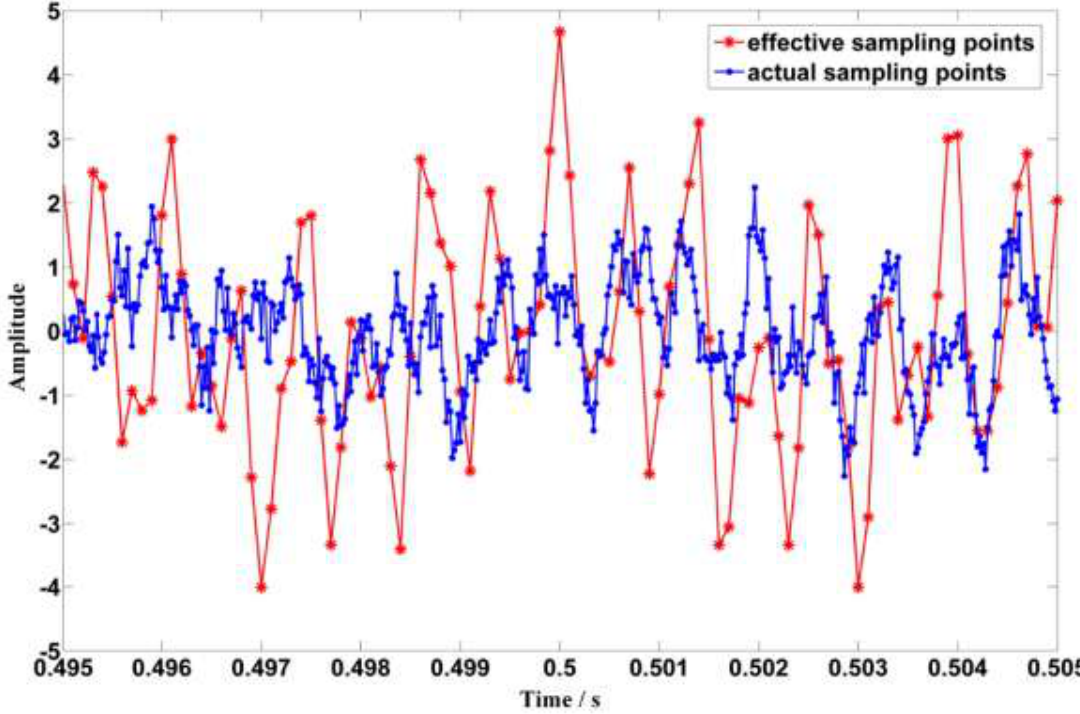
Figure 8. Comparison between the actual sampling series and the demodulated effective sampling series when the actual sampling frequency is 50 kHz.